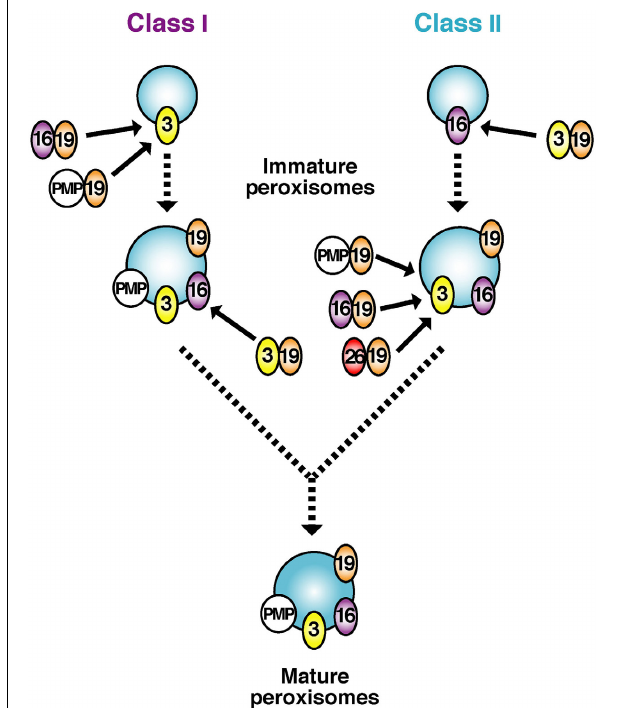
FIGURE 3 | A model for early stages of peroxisomal membrane biogenesisinvolvingmutuallydependenttargetingofPex3pandPex16p, namedclassesIandIIpathways. TheinitialmembranesharboringPex3por Pex16p culminate in indistinguishable, matured peroxisomes. Pex19p forms complexesinthecytosolwithnewlysynthesizedPMPsincludingPex16pand C-tailedanchoredmembraneproteinssuchasPex26pandtransportsthemto the membrane protein receptor Pex3p, whereby peroxisome membrane is assembled (Class I pathway). With respect to biogenesis of Pex3p, Pex19p likewiseformsacomplexwithnewlysynthesizedPex3pandtranslocatesitto the Pex3p receptor, Pex16p (Class II pathway). Of note, peroxisomes